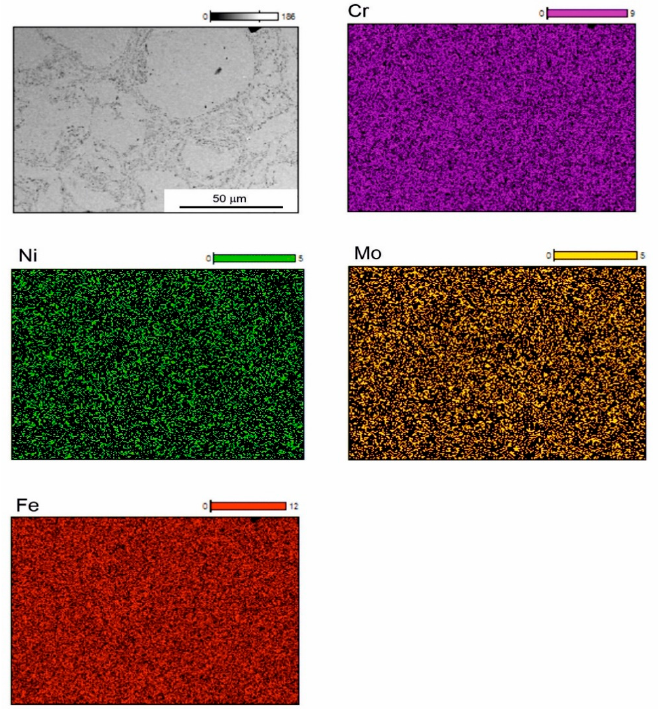
Figure 4. Distribution of the elements in the sample sintered at 900 °C.